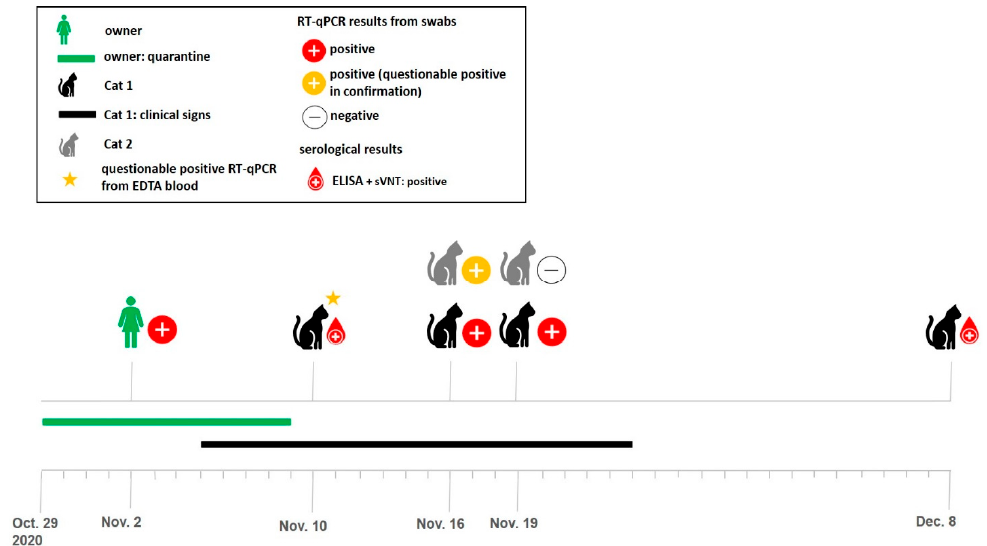
Figure 1. Timeline of the sample collections and overview of test results in the two cats (Cat 1 and Cat 2) after one of the two cat owners had tested RT-qPCR positive for severe acute respiratory syndrome coronavirus-2 (SARS-CoV-2). Cat 1 (indicated with the black cat-pictogram) became symptomatic on 5 November 2020 and was presented to a private practitioner on 10 November 2020, where a blood sample was collected. Swab samples from both cats were collected on 16 and 19 November 2020. Serological testing (ELISA and sVNT) was performed on serum from Cat 1 collected on 10 November and 8 December 2020. Cat 2 is indicated gray. Results of RT-qPCR and serology are indicated by colors as shown in the legend. (EDTA: ethylenediamine tetra-acetic acid, ELISA: enzyme-linked immunosorbent assay, sVNT: surrogate virus neutralization test, and RT-qPCR: real-time quantitative reverse transcriptase-polymerase chain reaction, CT: cycle